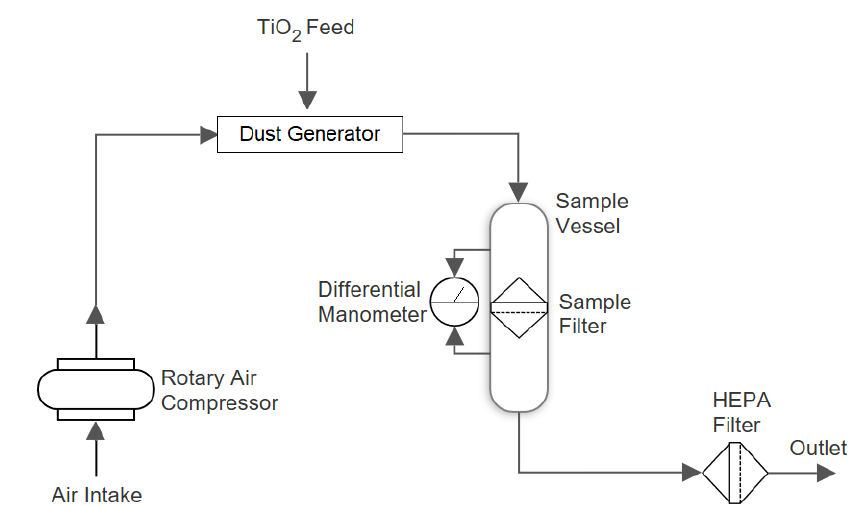
Figure 2. Diagram showing the components used in the flow rig set-up in I13-2: the air compressor generates the head pressure used to flow the aerosol through the rig. TiO 2 is aerosolized in the dust generator by flowing the compressed air over a dosing ring that holds the nanopowder. A differential digital manometer is used to measure the pressure loss across the filter as the aerosol flows through the sample holder. A High Efficiency Particle Air (HEPA) filter is used as an exhaust filter to prevent contamination of the hutch